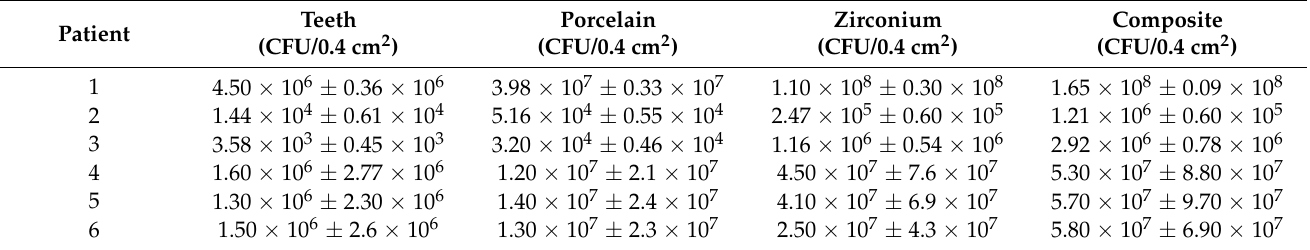
Table 1. Average number of microorganisms on the composites, porcelain, zirconium, and the teeth surface (detected by the culture dependent